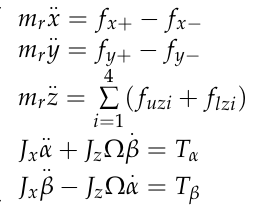
Figure 3. The structure and force models of the 3 ‐ DoF axial AMB. ( a ) The upper end of the 3 ‐ DoF axial AMB; ( b ) the force distributions of the 3 ‐ DoF axial AMB; ( c ) the force distributions of the 3 ‐ DoF axial AMB.